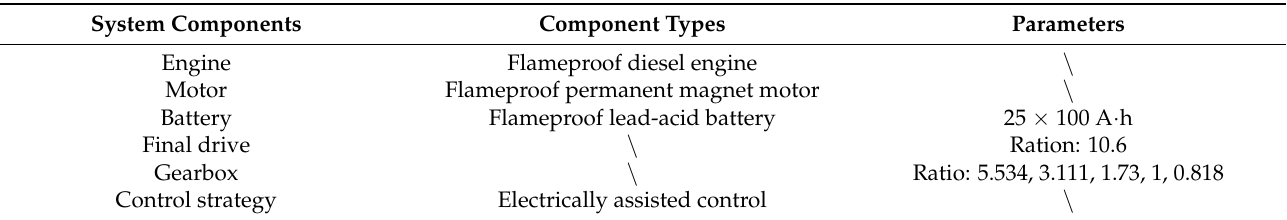
Table 2. Power system parameters for HETRTV.